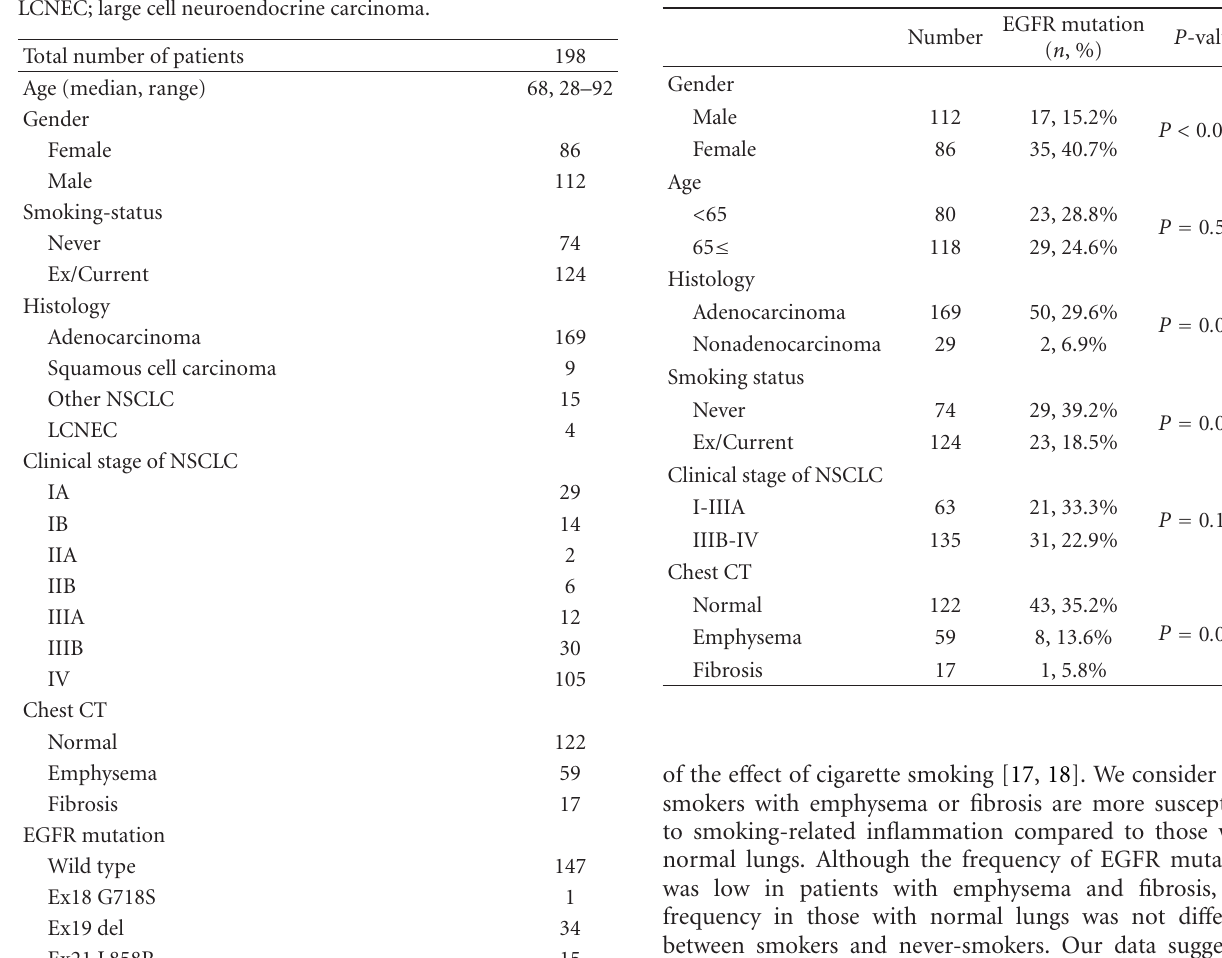
Table 2: Patient characteristics and EGFR mutation